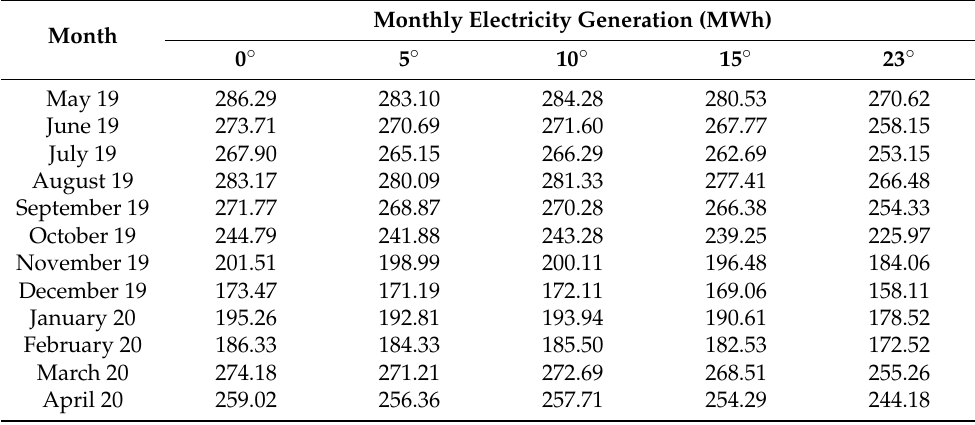
Table 7. The monthly electricity generation under different tilt